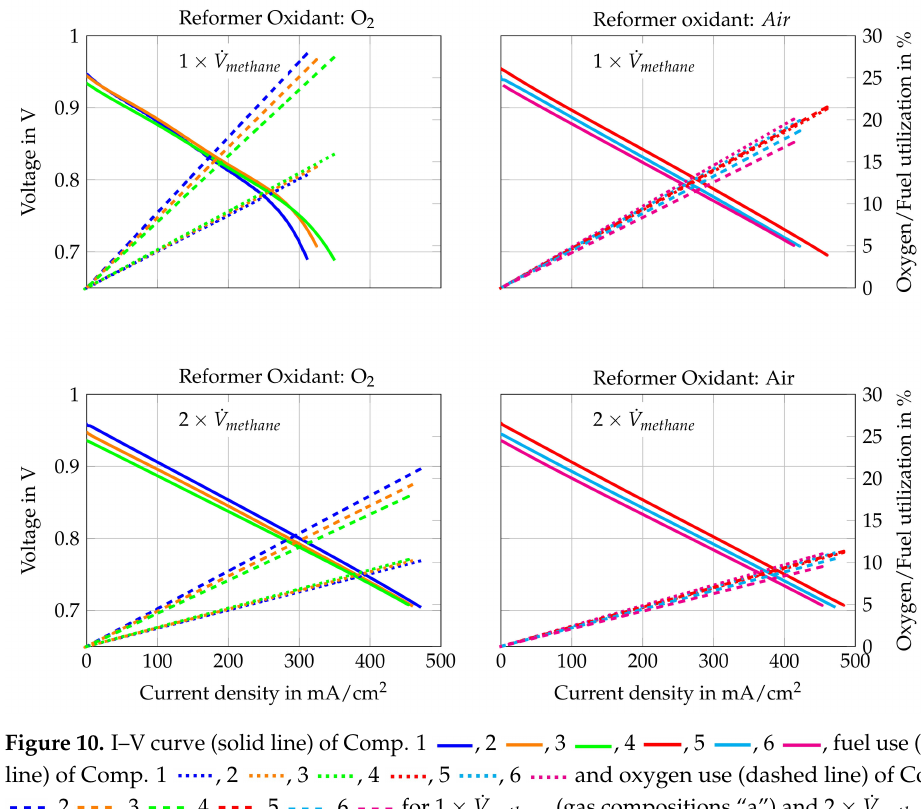
Figure 10. I–V curve (solid line) of Comp.